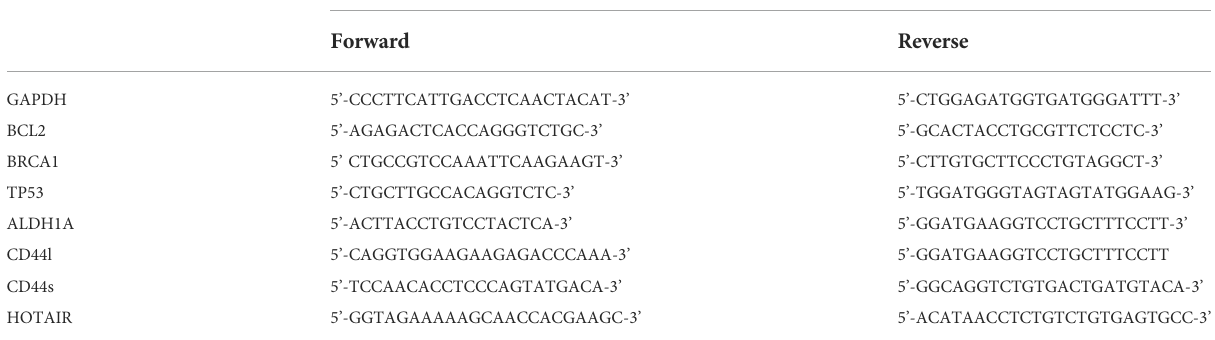
TABLE 2 Sequences of primers used for RT-PCR validation.